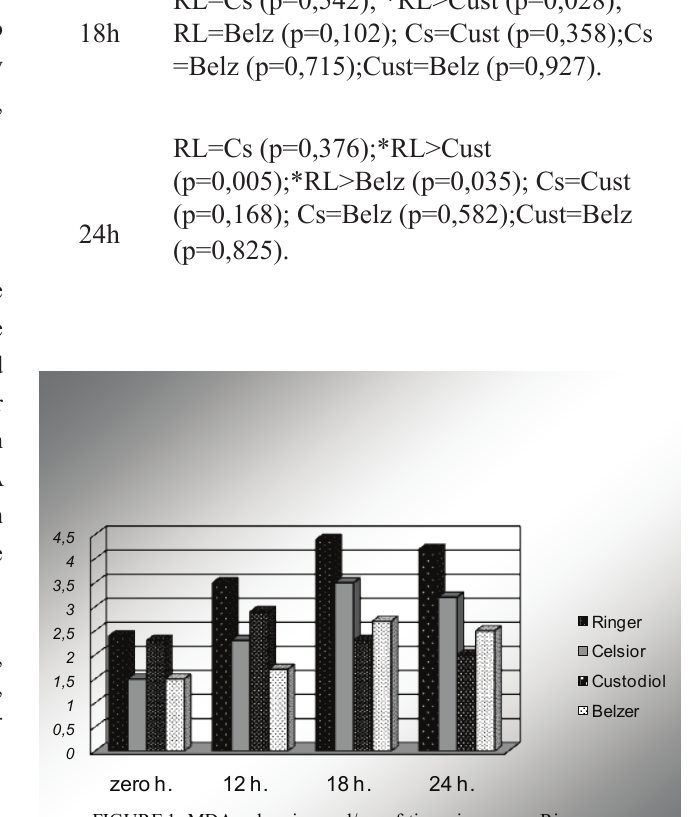
FIGURE1: MDA values in nmol/mg of tissue in groups Ringer, Celsior, Custodiol and Belzer without ischemic preconditioning atzero, 12. 18, and24h. of